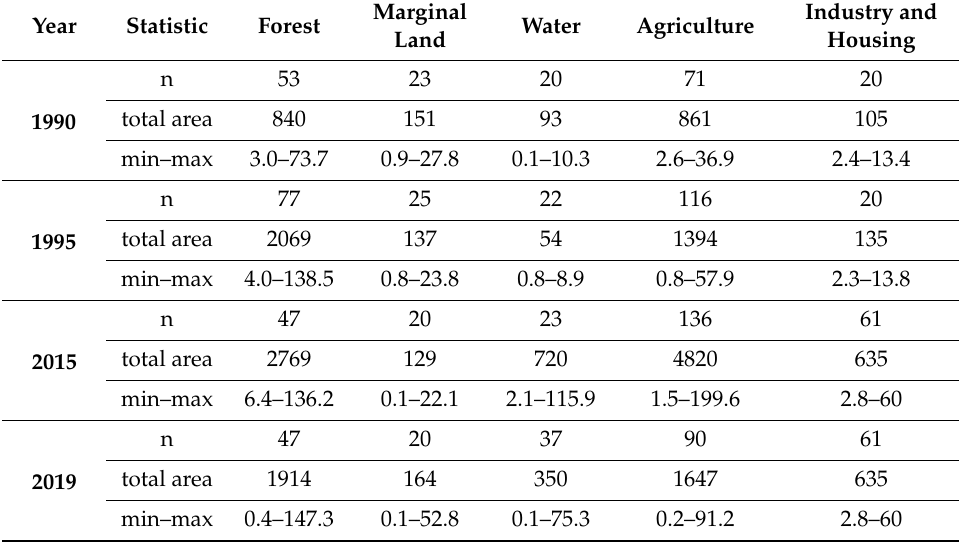
Table A2. Training sample sizes (n), total area of samples (ha) and minimum to maximum sample size (ha) for land cover classification purposes in Binh Thuan province for selected years (1990–2019). The locations of samples are provided in Figure